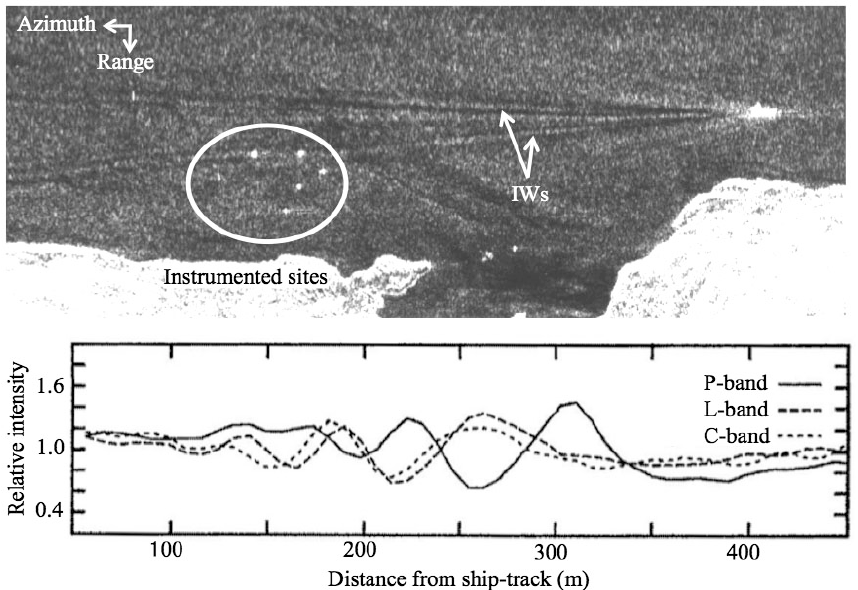
Figure 13. Upper: X-band SAR image of IWs and instrumented sites in Loch Linnhe, Scotland Figure 13. Upper: X–band SAR image of IWs and instrumented sites in Loch Linnhe, Scotland (5 × 2 km). Lower: Relative intensity modulation of multi–frequency AIRSAR images. (5 × 2 km). Lower: Relative intensity modulation of multi-frequency AIRSAR